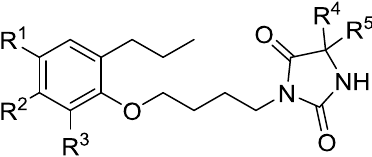
Figure 4. 3-(4-(2-propylphenoxy)butyl)imidazolidine-2,4-dione based LXRα/β dual agonists.